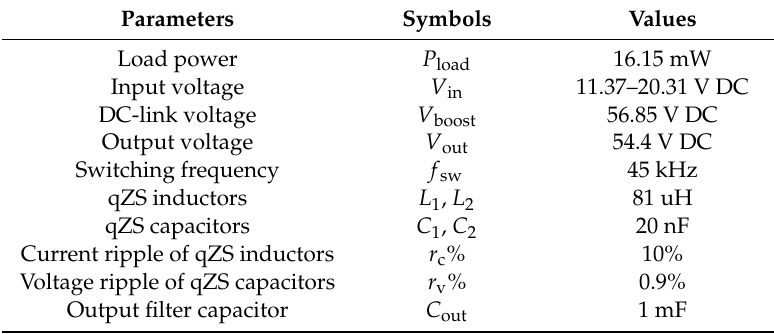
Table 5. Specifications of the